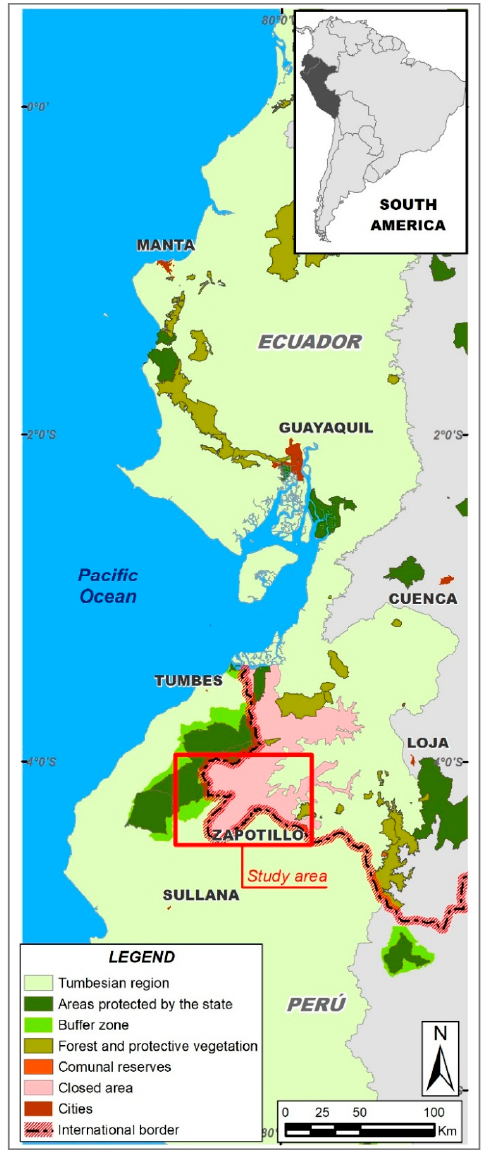
Figure 1. Study area in the Tumbesian region. Modified from “ La Región Tumbesina–una riqueza compartida ” [20].